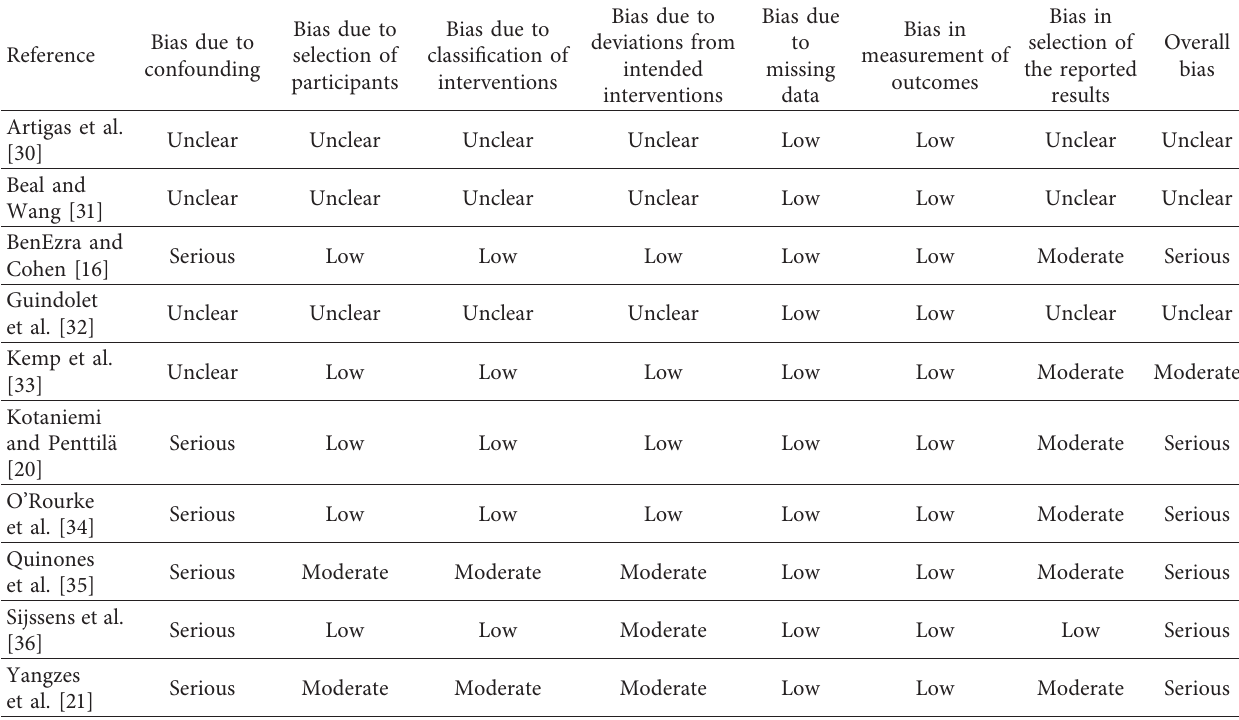
Table 4: Risk of bias assessment for each study using the Risk of Bias in Nonrandomized Studies of Interventions (ROBINS-I) tool.